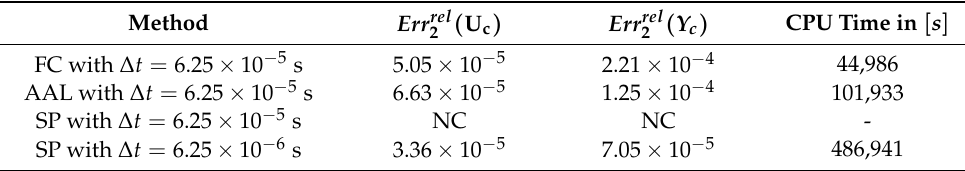
Table 3. Free fall of a dense cylindre—Values of Err rel and SP at the end of the simulation for t = 0.144 s, on a grid of size 400 × 800. NC indicates the simulation stopped due to divergence of the